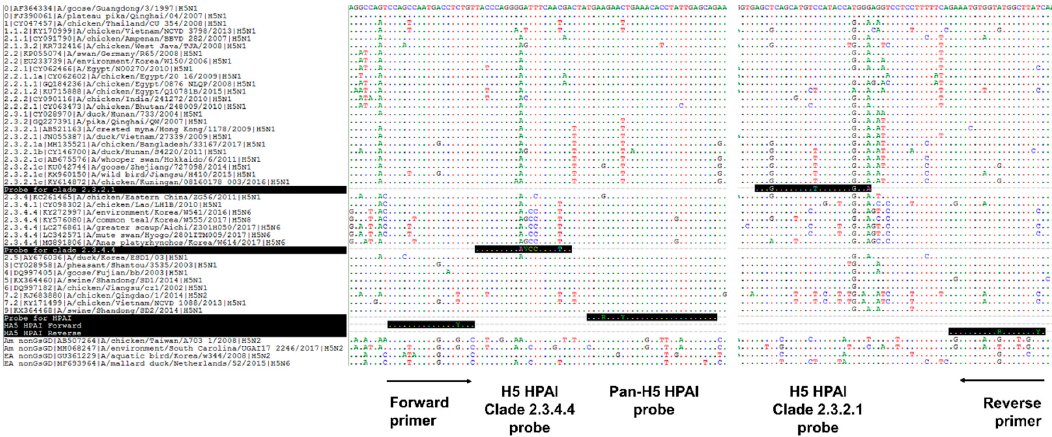
Figure 1. Design of the primer / probe set for the one-step multiplex RT-qPCR assay. Alignment of nucleotide sequences within the hemagglutinin (HA) gene of H5Nx avian influenza viruses that are representative of highly pathogenic avian influenza (HPAI) clades and low pathogenic avian influenza (LPAI) virus. The sequences of primers and probes specific to each target are on black background, and the reverse primer and probe specific for clade 2.3.2.1 show reverse complement sequence (R = A/G, Y = C/T, V = A/C/G). Table 1. Sensitivity of the single and multiplex assays.